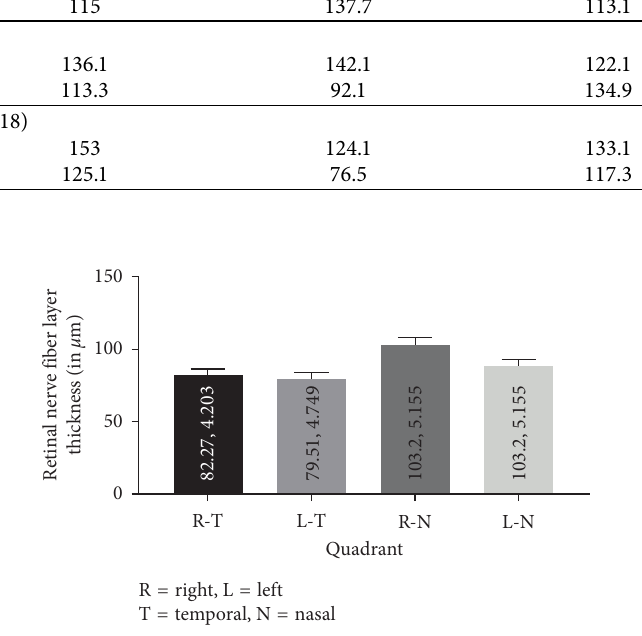
Figure 3: The distribution of the RNFL in each quadrant wise. Retinal nerve fibre layer thickness for each zone (mean, standard error of mean).